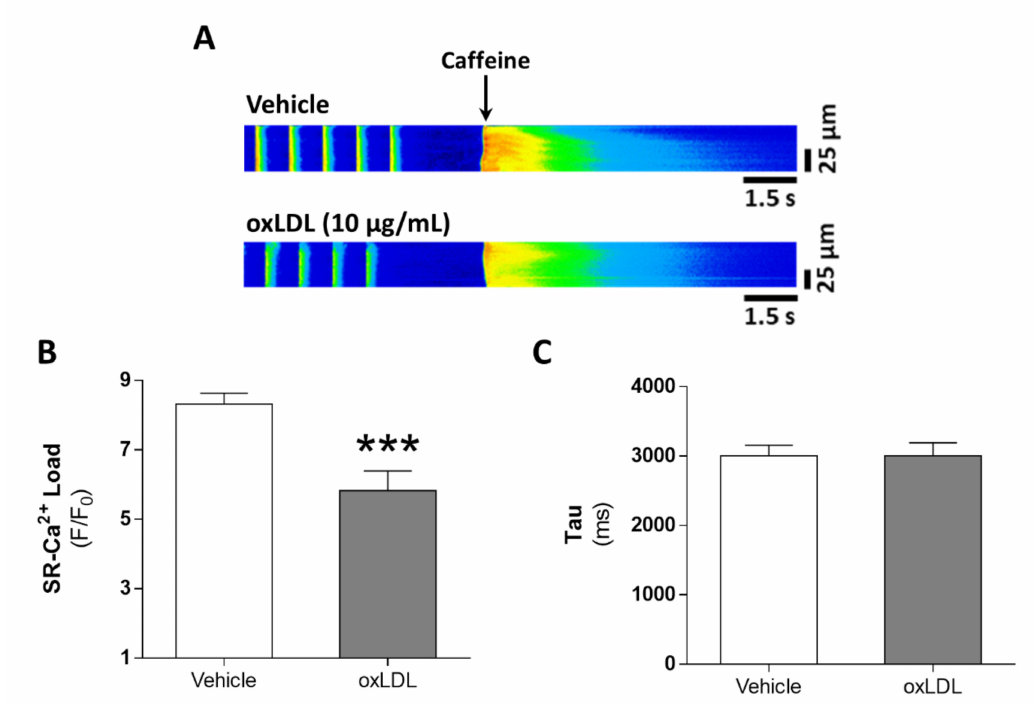
Figure 3. Acute e ff ects of oxLDL on sarcoplasmic reticulum-Ca 2 + load. ( A ) Representative line-scan images of a cardiomyocyte perfused with vehicle (upper panel) or with 10 µ g / mL oxLDL (lower panel) under 1 Hz field stimulation and in the presence of ca ff eine. Mean values of ca ff eine-induced Ca 2 + transients amplitude ( F / F 0 , B ) and decay time constant after ca ff eine perfusion (tau, C ) in cardiomyocytes treated with vehicle (n = 17 cells, N = 5 rats) or 10 µ g / mL oxLDL (n = 20 cells, N = 5 rats). *** p < 0.001 versus vehicle-treated